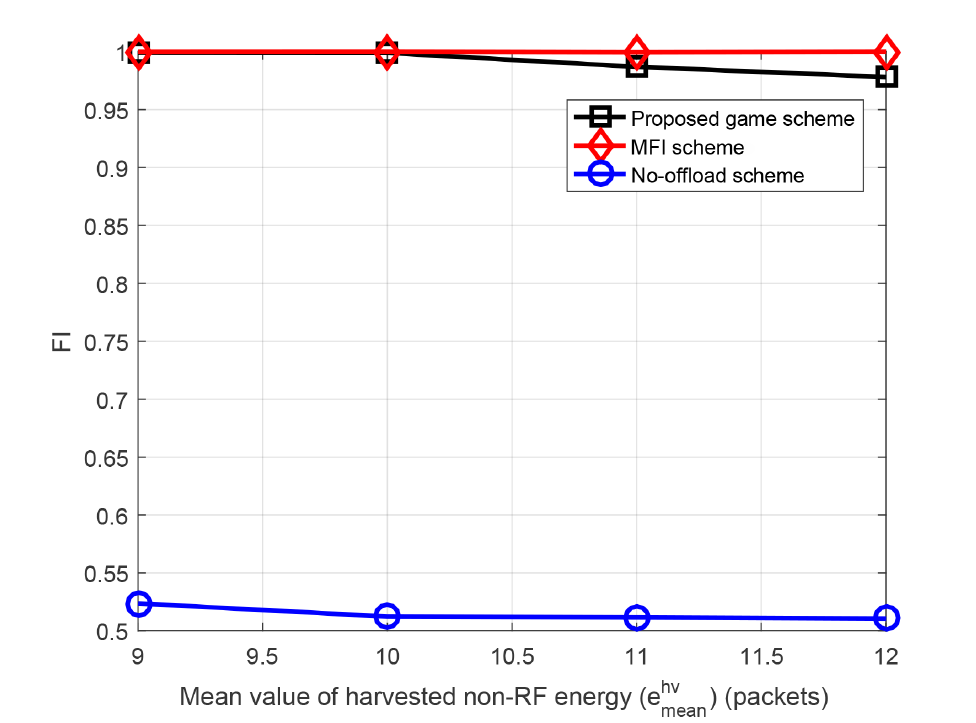
Figure 3. The influence of mean harvested non-RF energy on FI value of the network when mean value of harvested non-RF energy is changed from 9 to 12